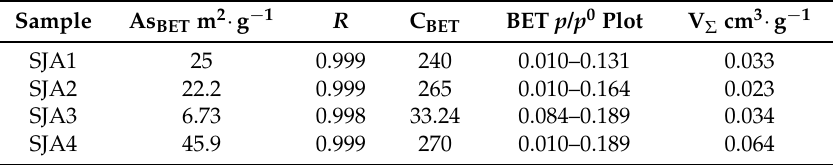
Table 2. N 2 adsorption data of soils samples of San Juan Amecac, Puebla, México.